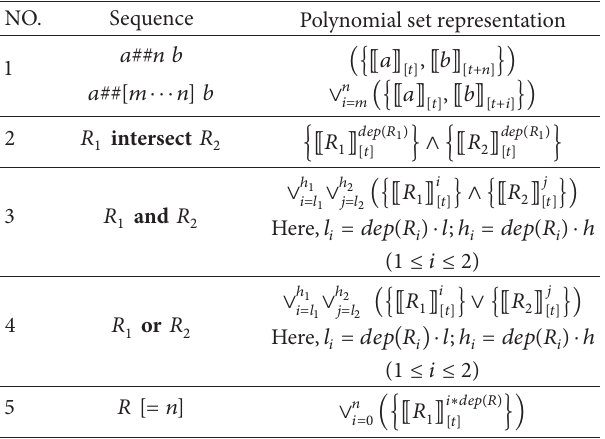
Table 2: Polynomial representation for sequence